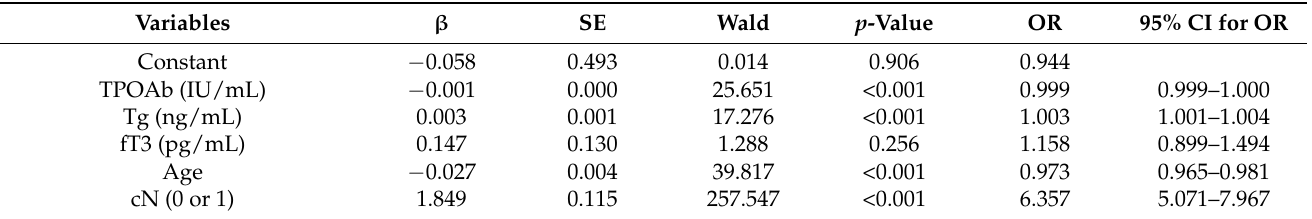
Table 4. Multivariable logistic regression analysis results of Tg, TPOAb, fT3 levels, age, and